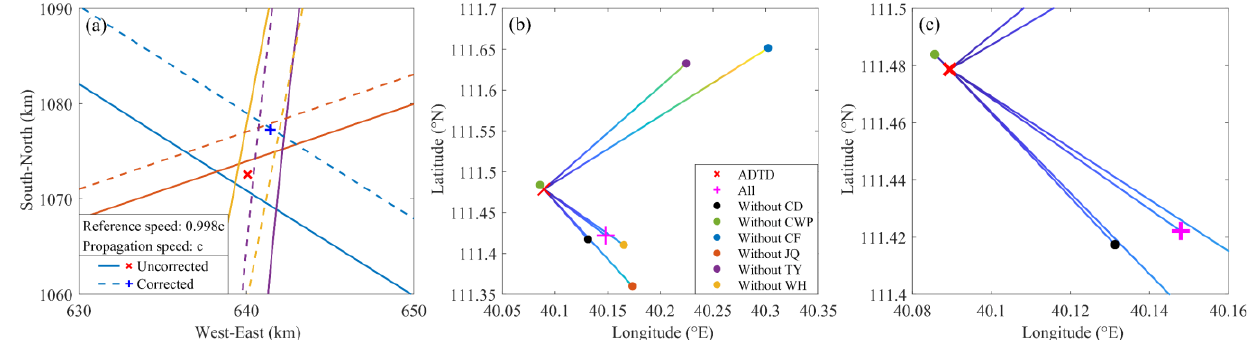
Figure 13. ( a ) Same as Figure 11, but with the hyperbola determined by CD – CWP removed. ( b ) The reference location of ADTD and the optimal locations calculated after correction by removing each station in turn and all six stations. The lines represent the deviation between the reference location and each optimal location. ( c ) The partial enlargement of ( b ).